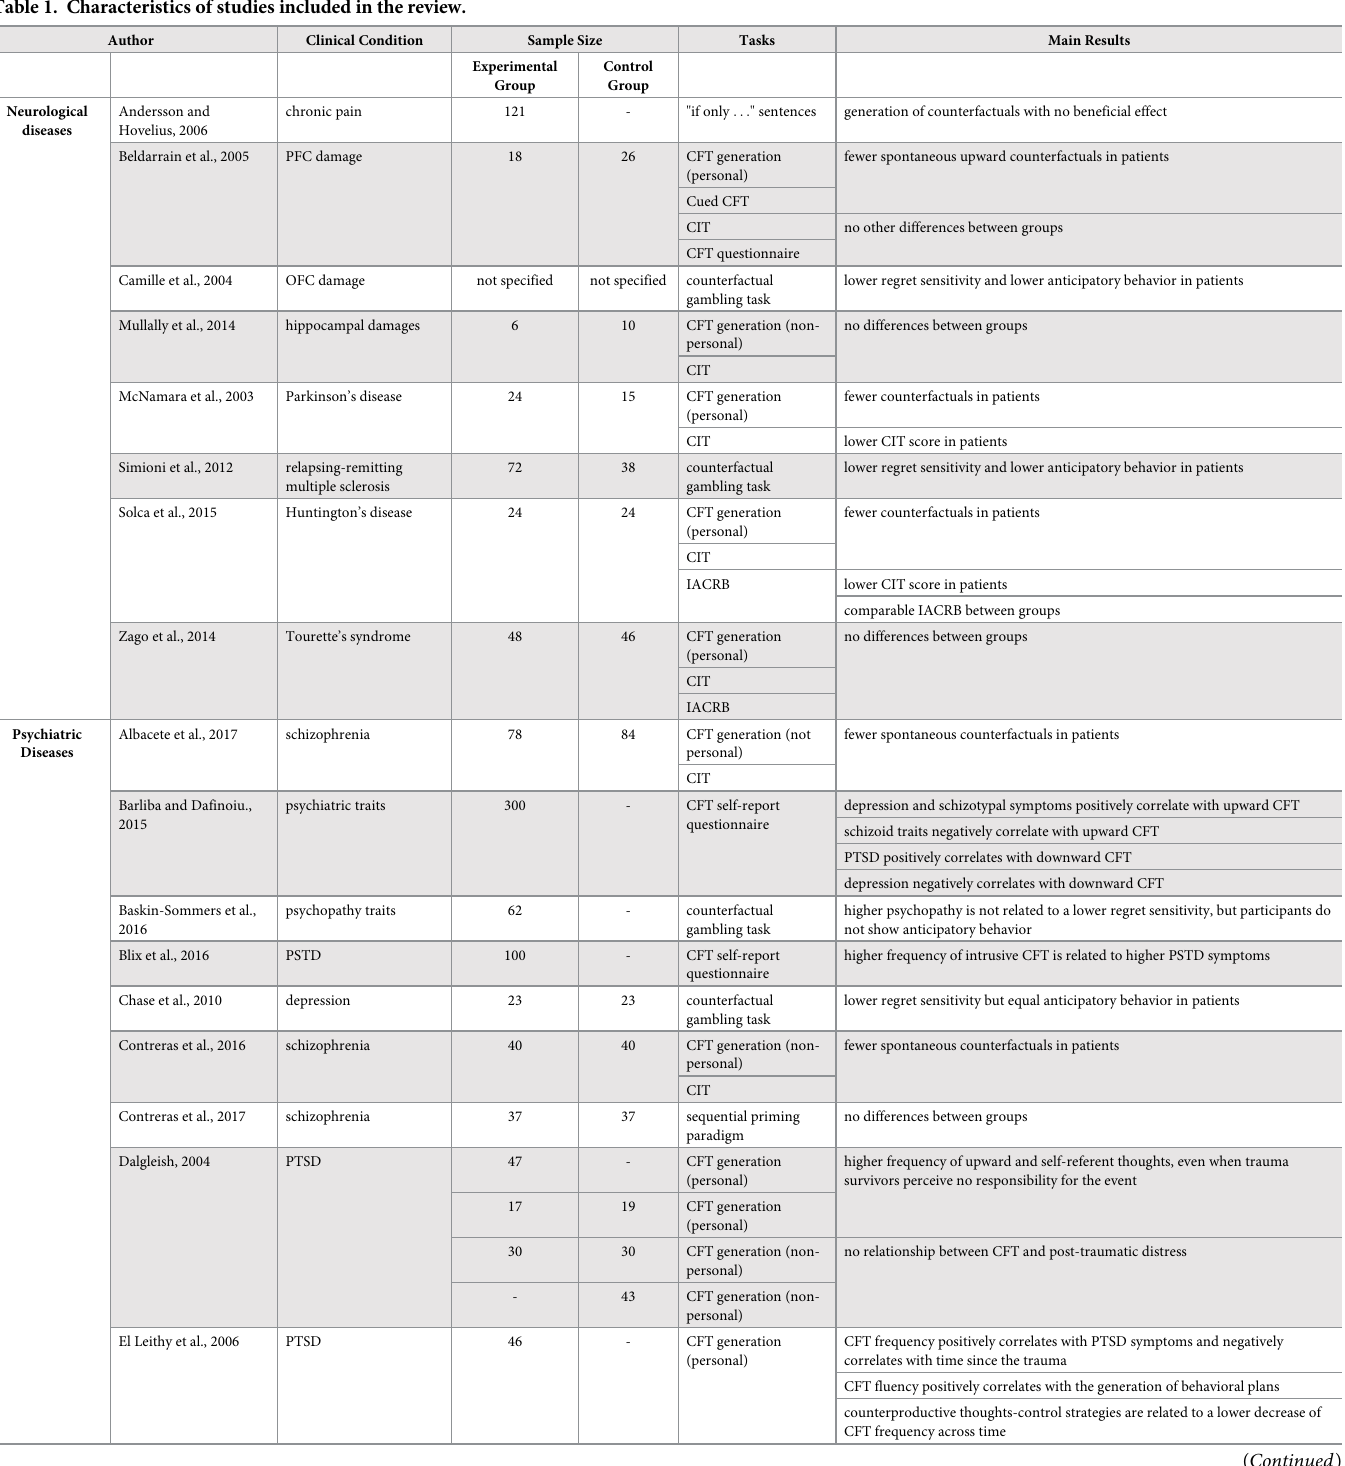
Table 1. Characteristics of studies included in the